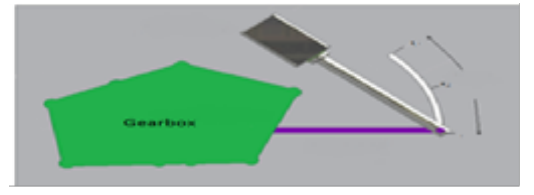
Figure 3 - Shifting the gear and then changing the seed rate using the electric operator idea.